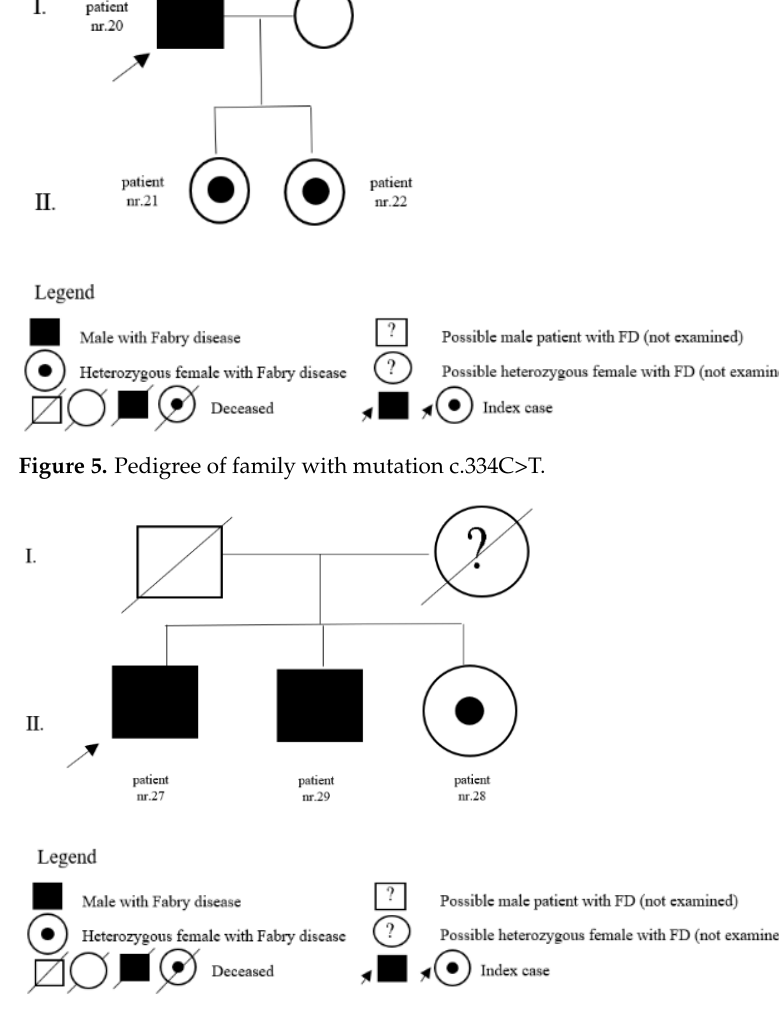
Figure 6. Pedigree of family with mutation c.758T>C.